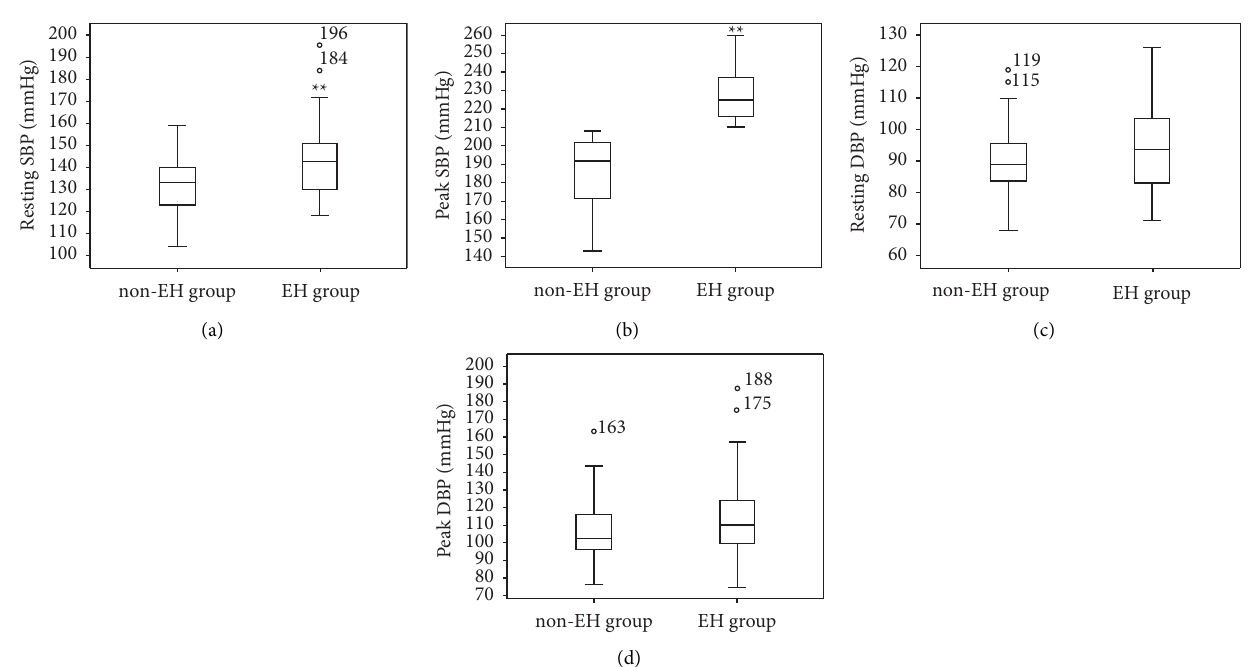
Figure 1: Comparison of resting and peak blood pressure between EH group and non-EH